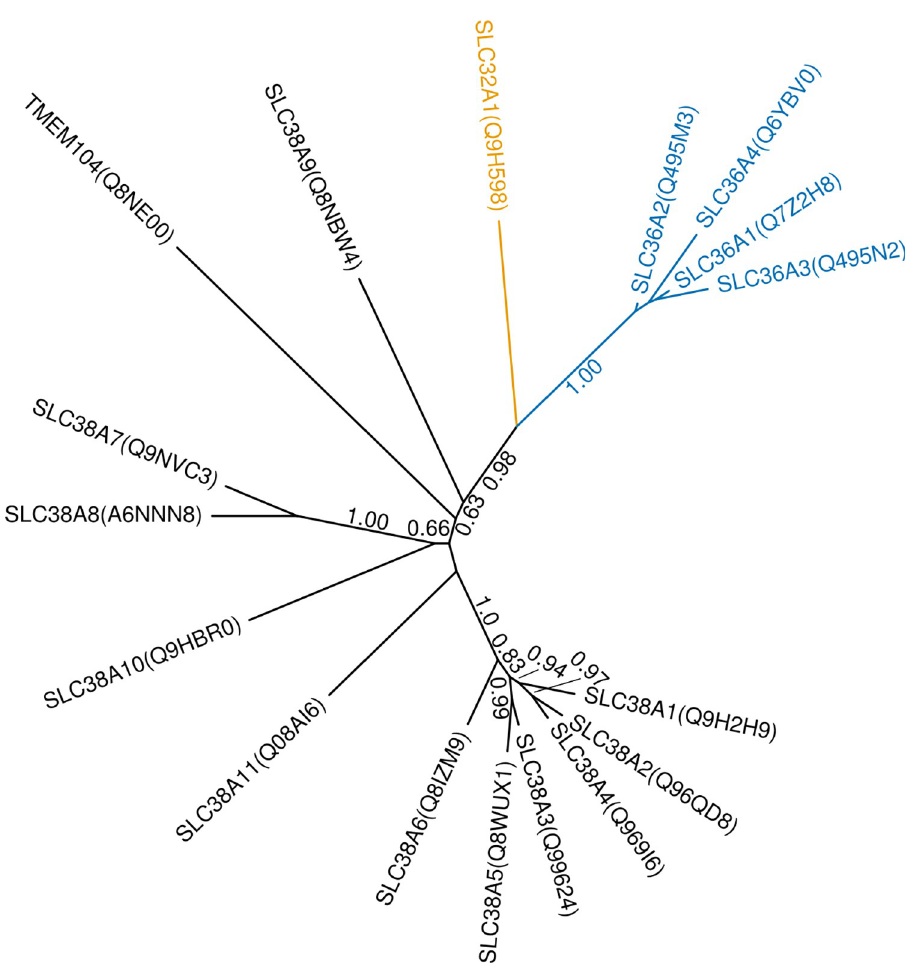
Fig 4. Phylogenetic tree of proteins clustering in the SLC38-36-32 families and TMEM104. Branch support values � 0.5 are shown. SLC32 and SLC36 family members are colored gold and blue, respectively.